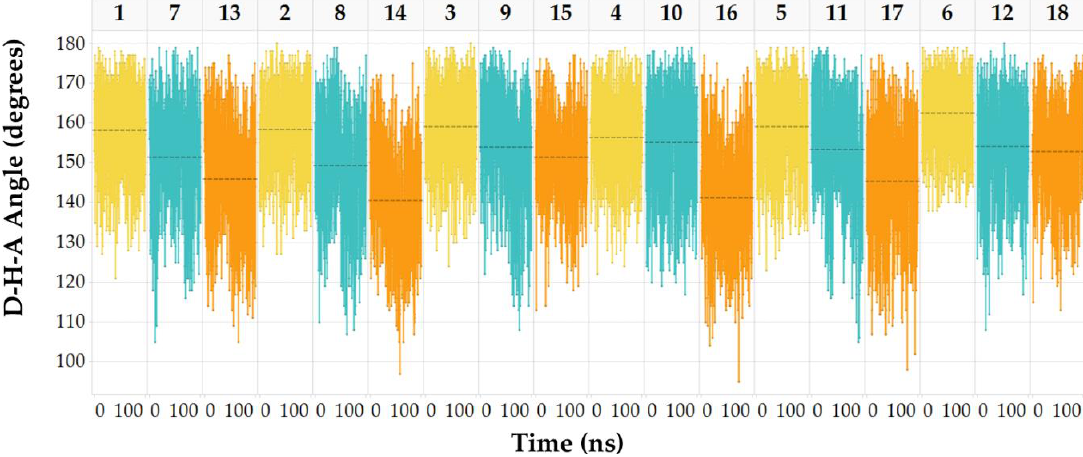
Figure 7. D-H-A angles (degrees) of the deep H-bond interaction across 100 ns simulation of 1 – 18 systems. The plots are ordered per INDZ-IMID 1-IMID 2 triplet and colored as yellow, cyan, and orange, respectively. Dashed lines correspond to the mean value of the D-H-A angle.